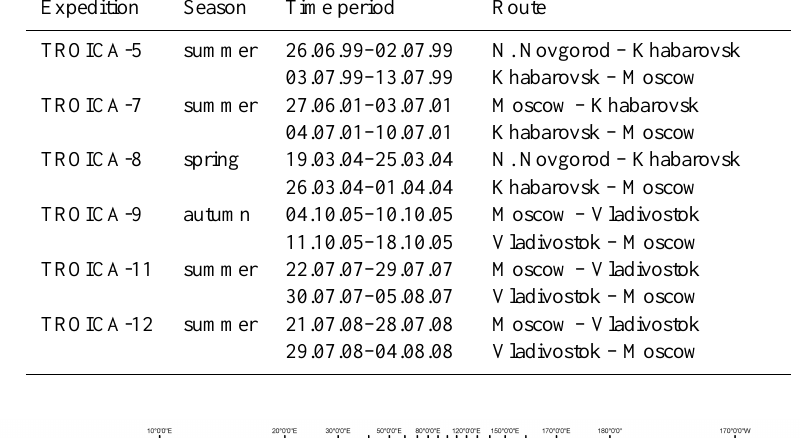
Table 1. TROICA expeditions: dates and routes.